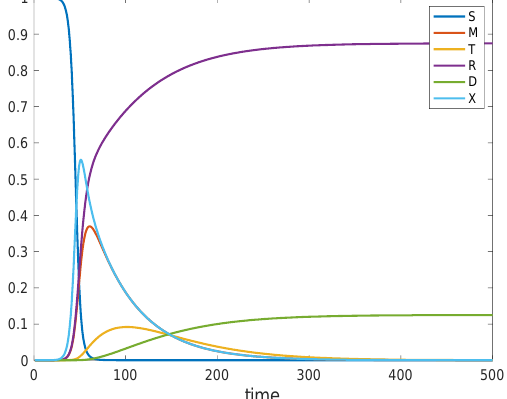
Figure 6. Simple SEIR model, 𝐾 = 22 , 𝛼 = 0.02 , 𝜖 = 0.1 , 𝜇 = 0.1 , 𝜏 = 𝛿 = 𝛾 = 𝜌 = 0.01 . Here and in the following figures, time is in days